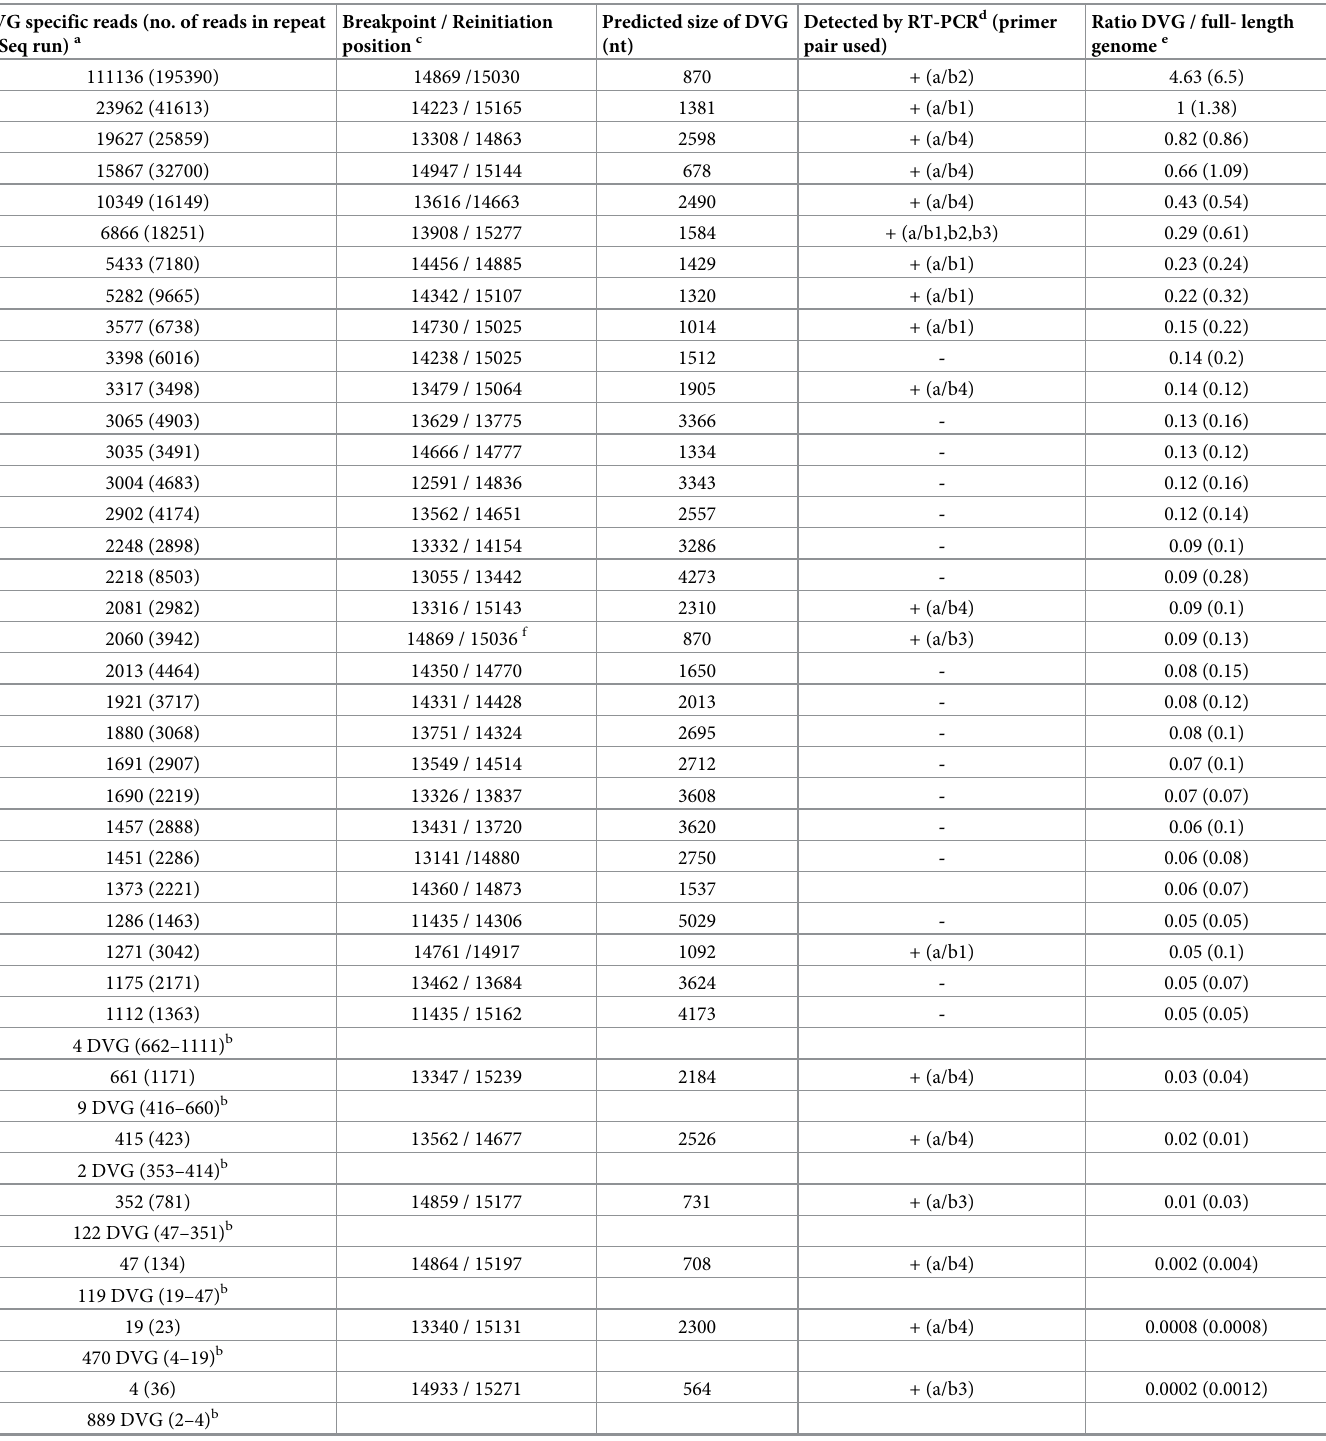
Table 2. 5’ copyback DVGs identified in virus #2 using